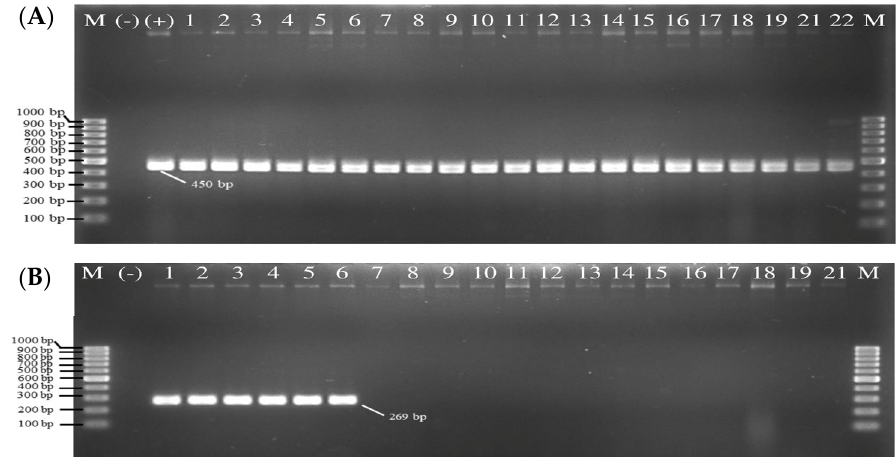
Figure 3. Gel electrophoresis of products of tlh primer ( A ) (Lane M: DNA marker, Lanes 1–22: representative samples, Lane ( − ): negative-control (DNA free template), Lane (+): positive-control ( V. parahaemolyticus PSU.SCB.16S.14) and products of tdh primer ( B ) (Lane M: DNA marker, Lanes 1–6: representative isolates of pathogenic V. parahaemolyticus , Lanes 7–21: representative isolates of non-pathogenic V. parahaemolyticus , Lane (-): negative-control (DNA free template), Lane (+).